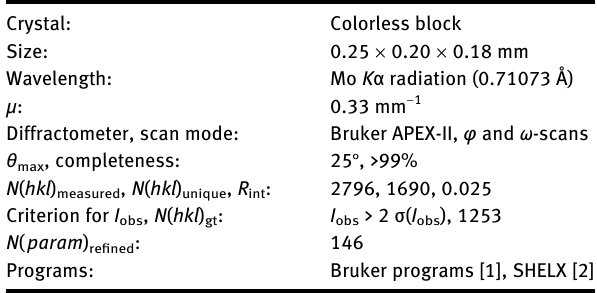
Table  : Data collection and handling. Crystal: